Question: What does this figure show? Answer in one sentence.
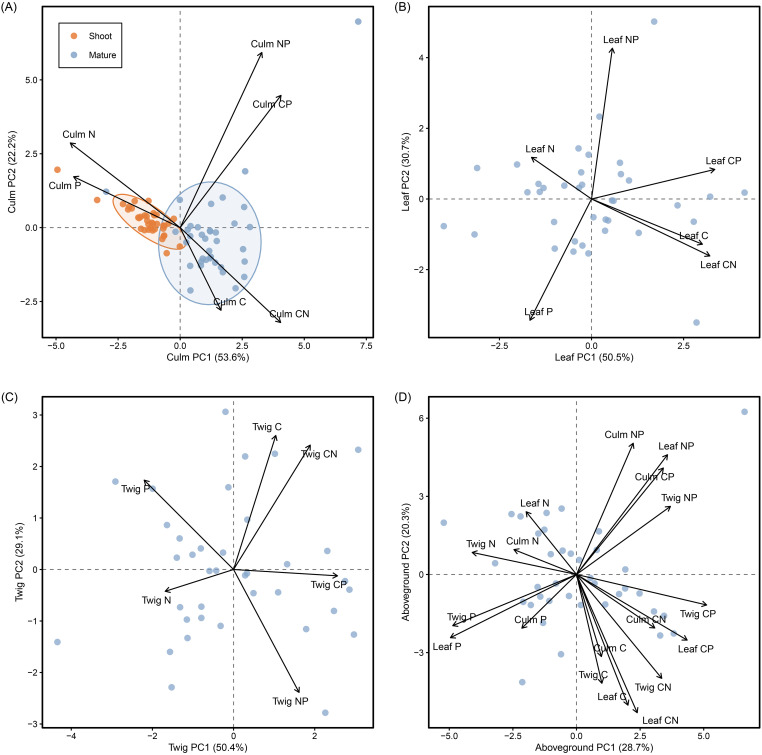
Answer: Principal component analysis (PCA) of Fargesia denudata. (A) Culm PCA of shoot and mature F. denudata , (B) leaf PCA of mature F. denudata , (C) twig PCA of mature F. denudata , (D) aboveground-level PCA of mature F. denudata . Arrows indicate trait loadings. Ellipses represent 95% confidence ellipses. C, C concentration; N, N concentration; P, P concentration; CN, C:N ratio; CP, C:P ratio; NP, N:P ratio. Each point represents a plot mean.